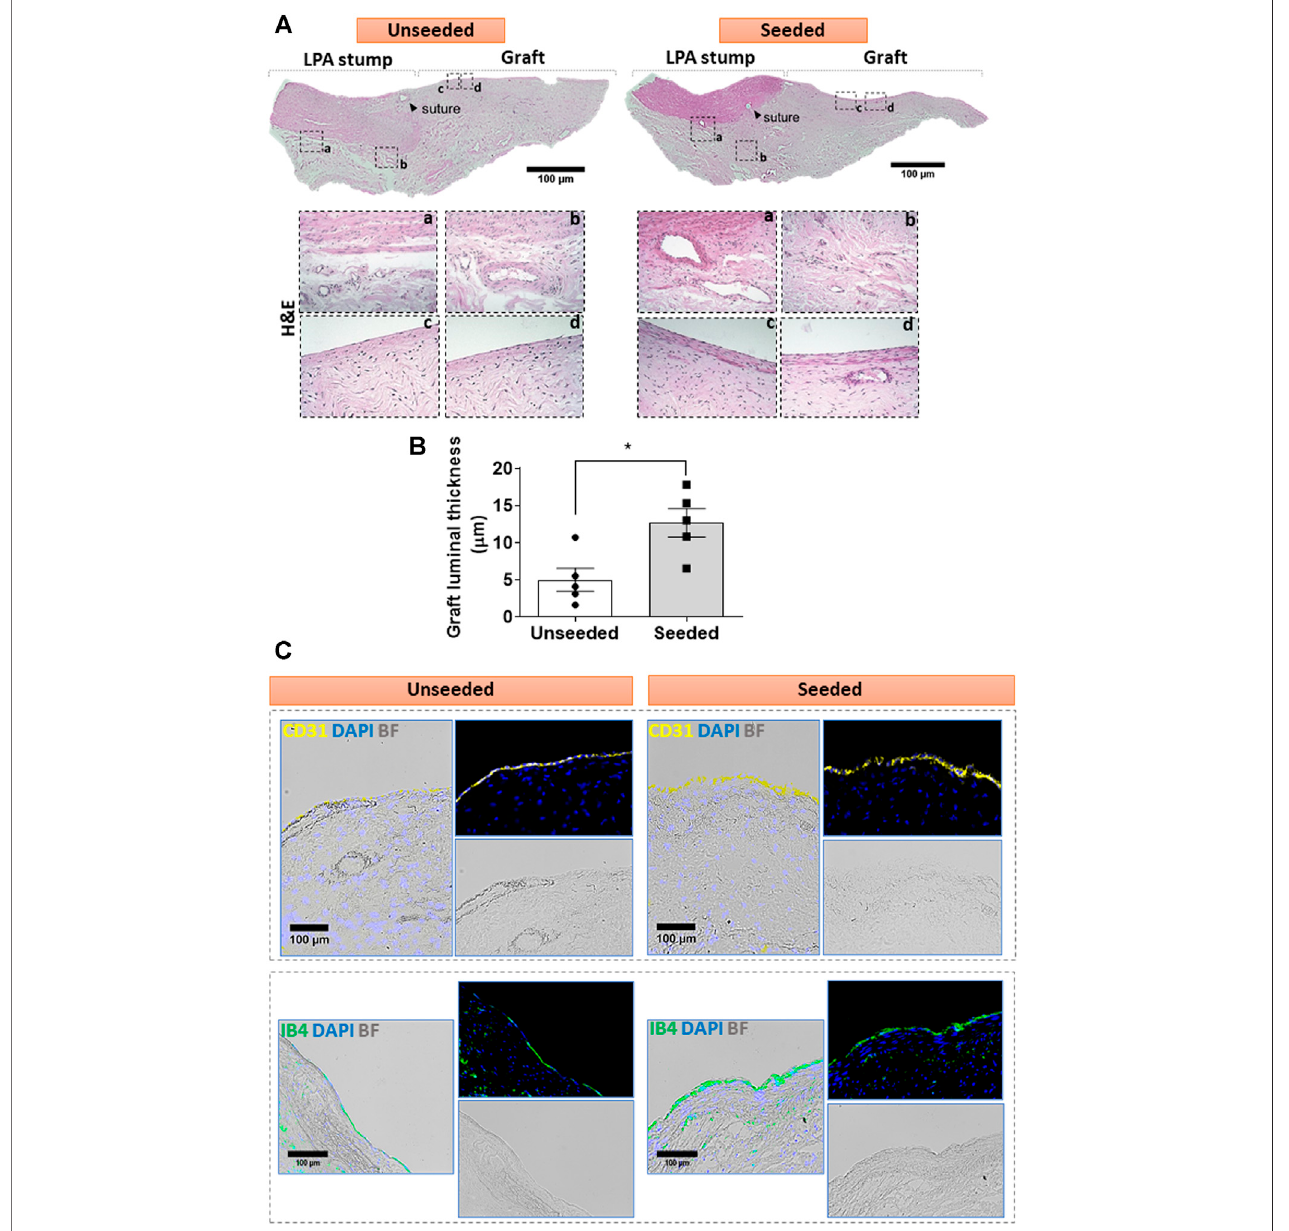
FIGURE2| Cellularcompositionofthegraft: (A) H&Estainingofunseededandseededgrafts.Tiledimagesandinsertsshowthegeneralarchitectureanddetailsof explanted grafts, including the distribution of cells (cell nuclei are dark blue and eosinophilic compounds in the cytoplasm are pink) and the ECM underneath the luminal cell layer, containing fi broblasts and microvessels. (B) Bar graph showing the thickness of the luminal layer. N (cid:1) 5 biological replicates per experimental group. Data are representedasmean ± SEM.* p < 0.05. (C) Immuno fl uorescentandbright- fi eldimagesdisplaythepresenceofCD31(yellow)andIB4(green)markersintheluminal endothelium of the grafts. Representative images are acquired using 2.5x, 10x, and 20x objectives.